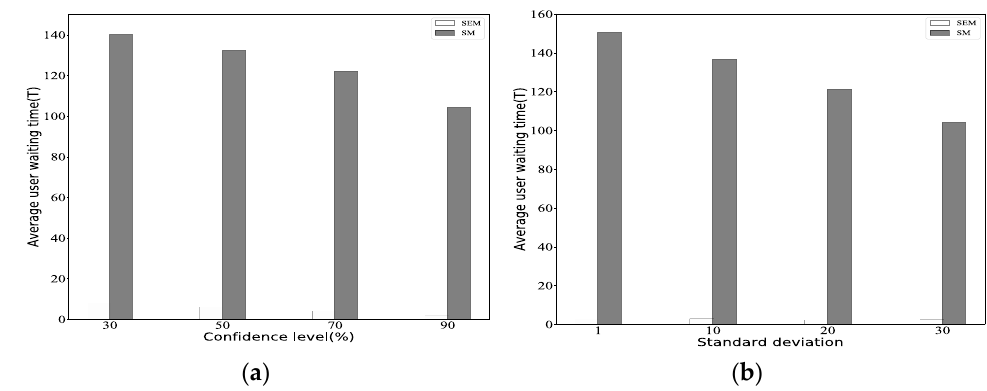
Figure 7. Average user waiting time for migration completion with respect to the estimated time section: ( a ) varies with the confidence level; ( b ) varies with the standard deviation.